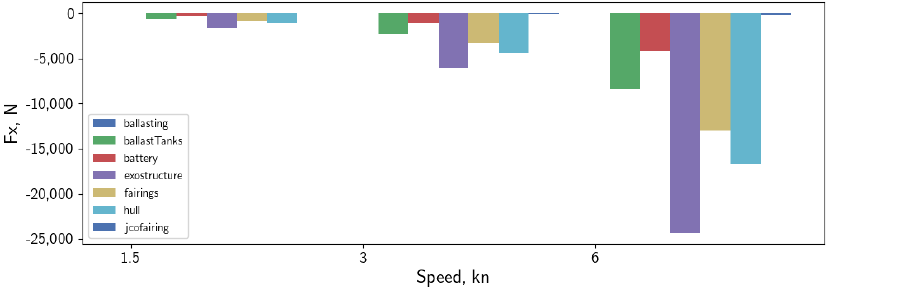
Figure 11. Resistance of individual patches of Geometry 3 when sailing at depth of 6